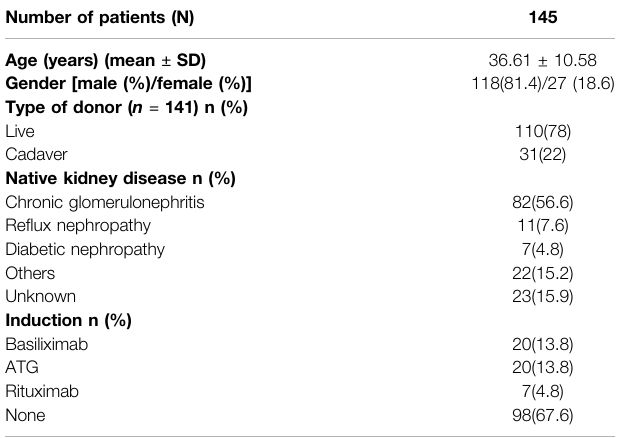
TABLE 1 | Baseline characteristics of the study